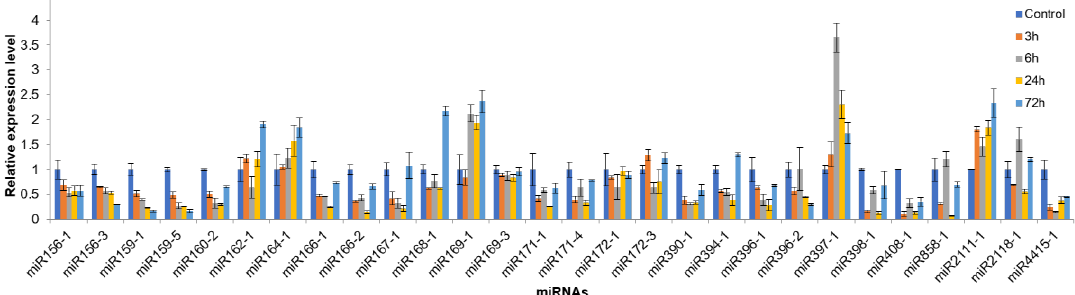
Figure 7. The expression patterns of conserved miRNAs under cold stress in A. membranaceus leaves. A. membranaceus U6 was used as an internal control. Error bars represent ±SD from three independent experiments.